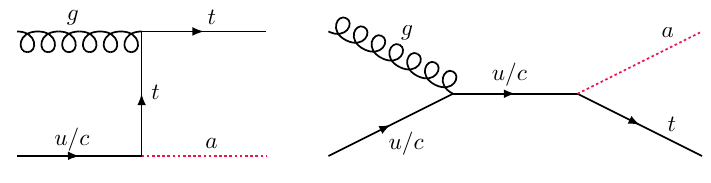
Figure 2 . The Feynman diagrams representing top + ALP production at the